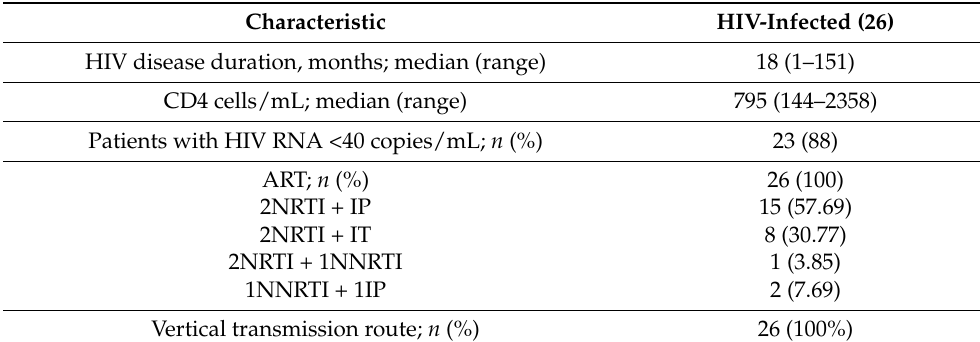
Table 2. Main features of perinatally HIV infected patients at enrollment.